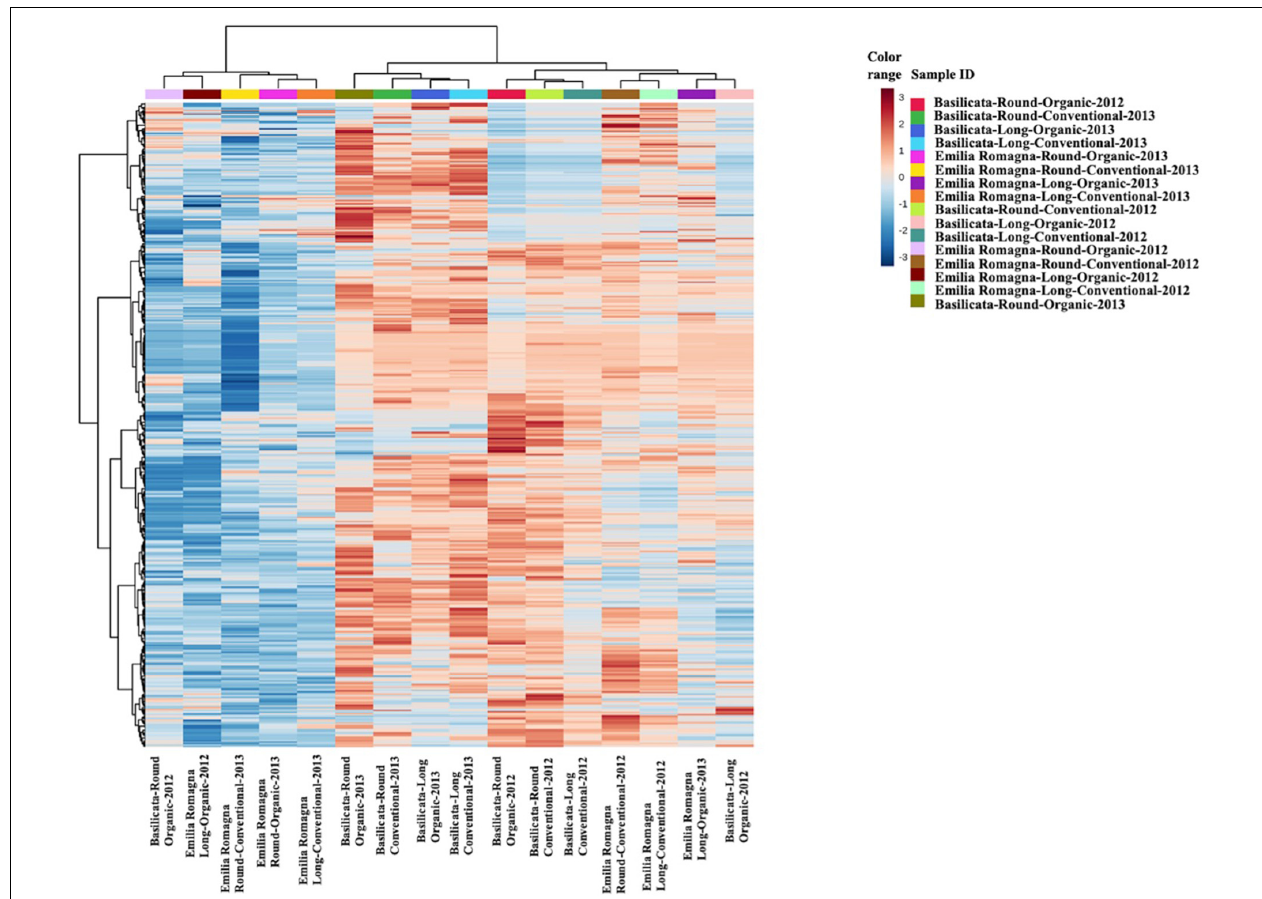
FIGURE 1 | Unsupervised hierarchical cluster analysis (HCA) (Euclidean distance) relative to untargeted phytochemical profile of tomato samples according to terroir, cultivar, and farming